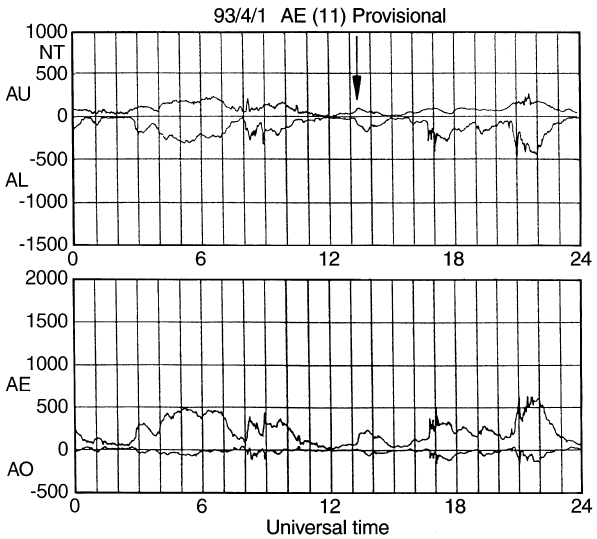
Fig. 9. The AE indices for 1 April 1993. The arrow indicates the onset of the substorm on the ground at 1310 UT, followed by the flux rope centred at 1331 UT.